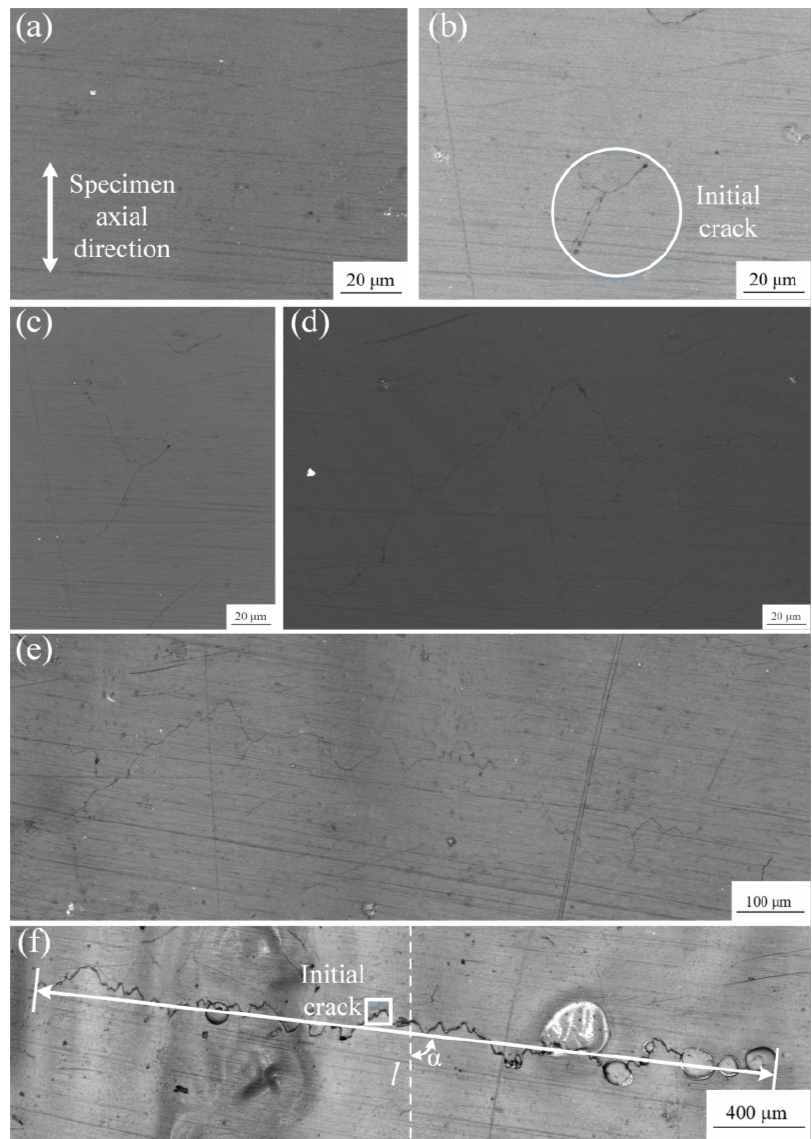
Figure 4. Replica film photos for specimen CRB1 after different numbers of cycles: ( a ) N = 0; ( b ) N = 130,000; ( c ) N = 250,000; ( d ) N = 300,000; ( e ) N = 400,000; ( f ) N = 500,000. Metals 2020 , 10 , 1267